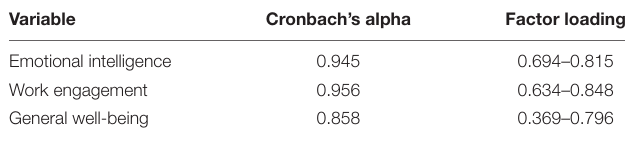
TABLE 1 | Questionnaire reliability and factor